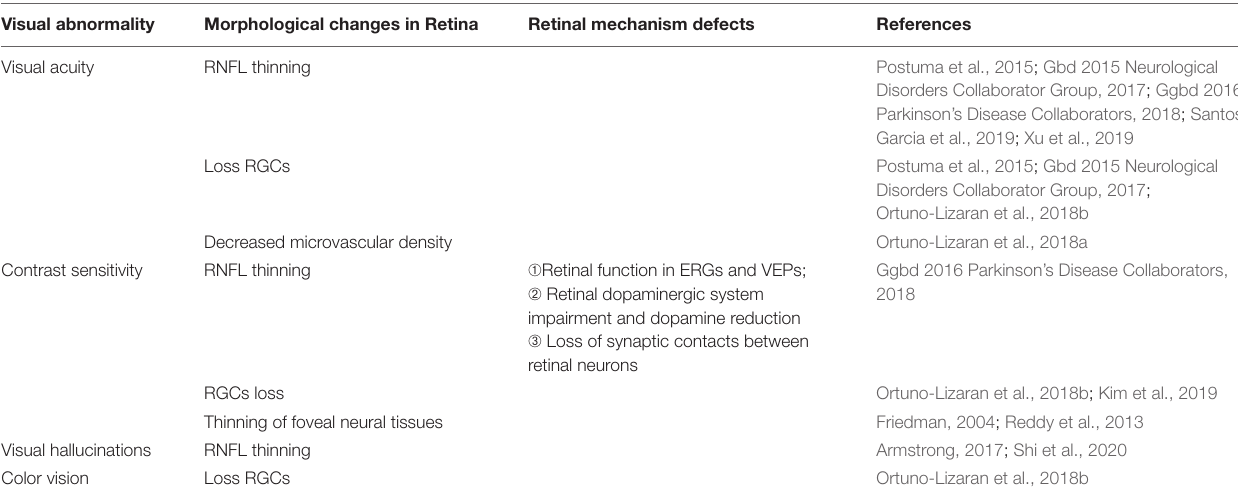
TABLE 3 | Retinal abnormalities in PD